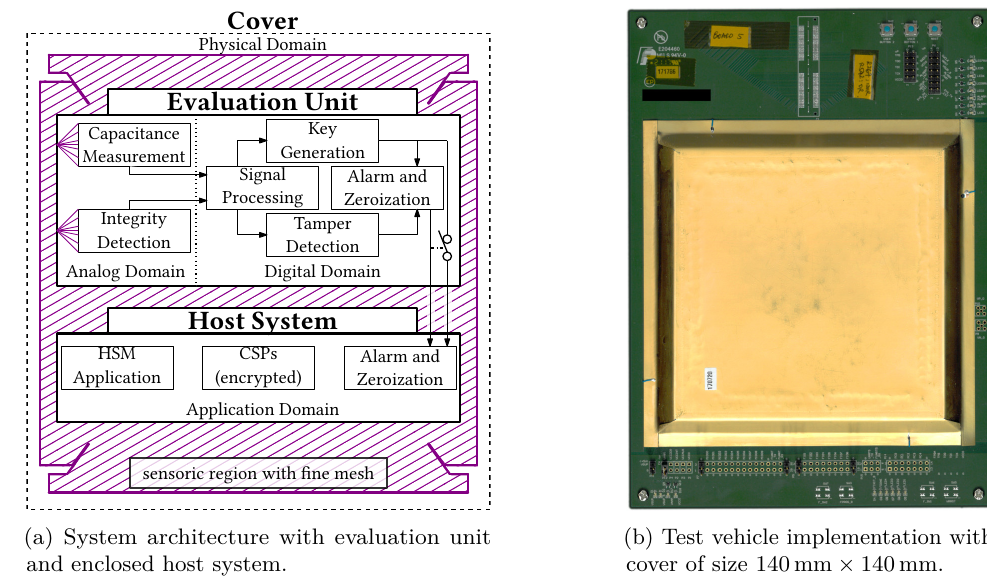
Figure 1: System architecture and test vehicle with preliminary assembly (prior to